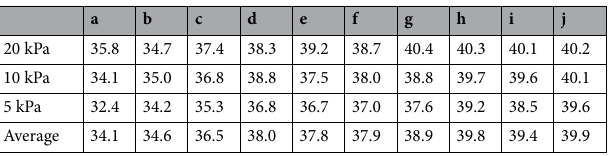
Table 4. Average values of φsf for 20, 10, 5 kPa and overall average values of salt samples a-j.